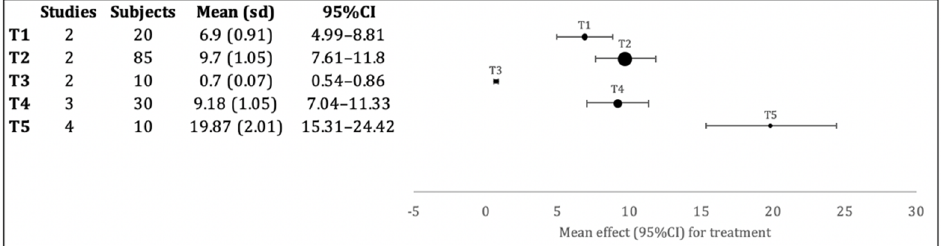
Figure 4. Forest plot of the evaluation of brackets adhesion to lithium disilicate ceramic with diverse superficial treatments. T1: Fine bur group; T2: Sandblasting (Al 2 O 3 ) group; T3: orthophosphoric acid group; T4: hydrofluoric acid group; T5: LASER group. For each surface treatment, the number of studies included, the totality of samples evaluated, mean and standard deviation (SD), and 95% confidence intervals are described. Adhesion values are presented in MPa.